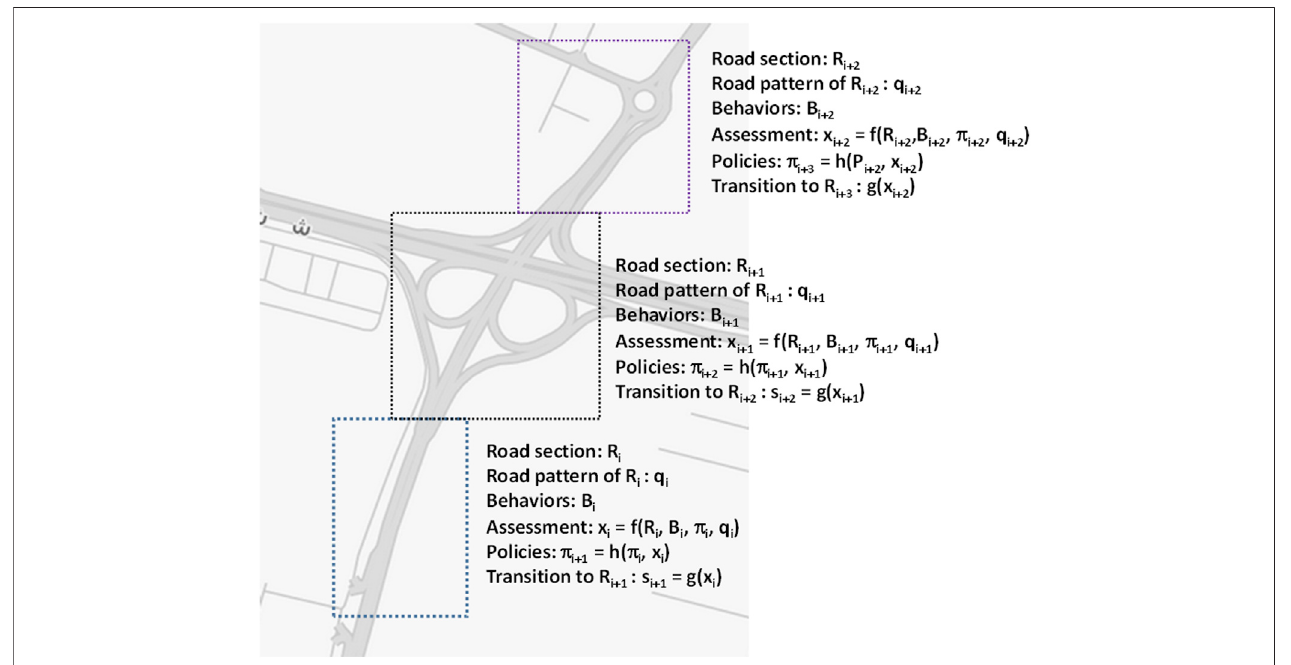
FIGURE 3 | Illustration of our system model concepts on a sample of road section.